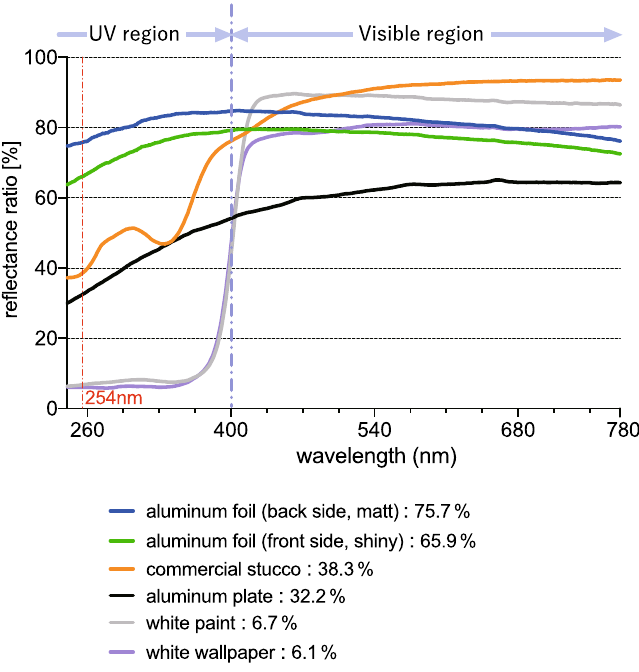
Figure 2. Reflectance ratios of various materials by UV and visible lights using UV–Vis–NIR concrete were 24.5%, 26.4%, 4.7%, 21.2%, and 14.9%, respectively (Supplementary Fig. S1). Among the materials measured in this study, the aluminum foil (backside, matt) showed the highest reflectance ratio. Changes in UV-C reflectance ratios and irradiance of Stucco by changing composition ratio and material. To increase the reflectance ratio of the commercial Stucco, the composition and the average particle diameters were changed. Standard commercial Stucco has Ca(OH) 2 as a main component, CaCO 3 as the second highest ingredient, and smaller amounts of sand, fibers, and a thickening agent as miscellaneous ingredi- ents. The basic components in the Stucco used in this study are mainly Ca(OH) 2 , CaCO 3 and a thickening agent. The UV-C reflectance ratios produced by changing the amount (%) of CaCO 3 are shown in Fig. 3a. The changes of the ratios produced by changing the average diameters of CaCO 3 particles at the fixed amount ratio (%) of CaCO 3 and Ca(OH) 2 are shown in Fig. 3b. The changes in ratios produced by replacing CaCO 3 with BaSO 4 were also examined (Fig. 4). By increasing the amount (weight %) of CaCO 3 by 45%, 50%, 70%, 80%, and 90%, the UV-C (254 nm) reflectance ratios were 61.3%, 65.5%, 63.8%, 69.0%, and 71.5%, respectively (Fig. 3a). By changing the average diameters of the CaCO 3 particles to 8.9 μm, 6.0 μm, 3.0 μm, and 1.0 μm, the respective reflectance ratios were 53.1%, 67.7%, 71.5%, and 73.4%, respectively (Fig. 3b). By increasing the amount (weight %) of BaSO 4 from 0 to 5%, 25%, 60%, and 90%, the reflectance ratios of UV-C (254 nm) showed higher from 54.1 to 61.1%, 66.8%, 60.5%, and 77.2%, respectively (Fig. 4a). By changing the average diameters of the BaSO 4 particles to 4.8 μm, 1.7 μm, 1.1 μm, 0.3 μm, the reflectance ratios were 59.6%, 65.7%, 70.1%, 77.2%, respectively (Fig. 4b). According to JIS A 6919, the amount of Ca(OH) 2 should amount to more than a half of the total Stucco. In the Stucco composition based on Standards in Japan, JIS A 6919 (Ca(OH) 2 54%, CaCO 3 (ps = 8.9 μm) 45%, with other ingredients, including a 1% thickening agent), the UV-C (254 nm) reflectance ratio was 45.0%, showing a rate close to the commercial Stucco. In addition, in the authors’ Modified Stucco composition, which we determined based on the characteristics of CaCO 3 and BaSO 4 stated above, that is, Ca(OH) 2 51%, BaSO 4 (ps = 0.3 μm) 25%, CaCO 3 (ps = 3.0 μm) 23% and 1% thickener, the UV-C reflectance ratio rose to 66.8% (Fig. 5). Next, UV-C irradiance at a distance of 75 cm from the direct UV-C lamp was 30 μW cm −2 . In contrast, UV-C irradiance at the agar media after passing through a test box with aluminum foil (back side, matt), authors’ Modified Stucco, commercial Stucco, and white wall paper was 148 μW cm −2 , 21 μW cm −2 , 6 μW cm −2 , and 1 μW cm −2 , respectively. Disinfection effects of UV-C reflected irradiation. The log reduction of E. coli and S. hominis in direct UV-C light was evaluated. The UV dose (Irradiance × exposure time) required to 5.928-log 10 reduction of E. coli was 3.6 mJ cm −2 . The UV dose required to 4.254-log 10 reduction of S. hominis was 18 mJ cm −2 (Supplementary Fig. S2).